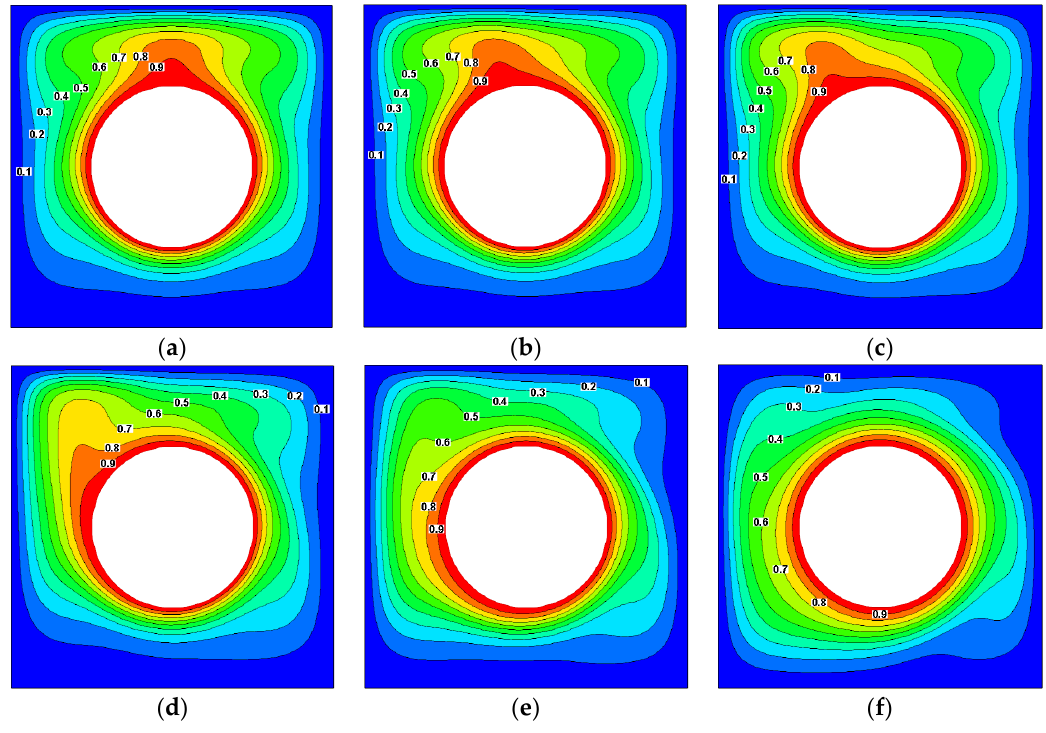
Figure 7. ( a ) N = 0, ( b ) N = 10, ( c ) N = 20, ( d ) N = 50, ( e ) N = 100, ( f ) N = 200. Contours of dimensionless temperature at λ = 0.5, Ha = 40 and Ra = 10 6 .